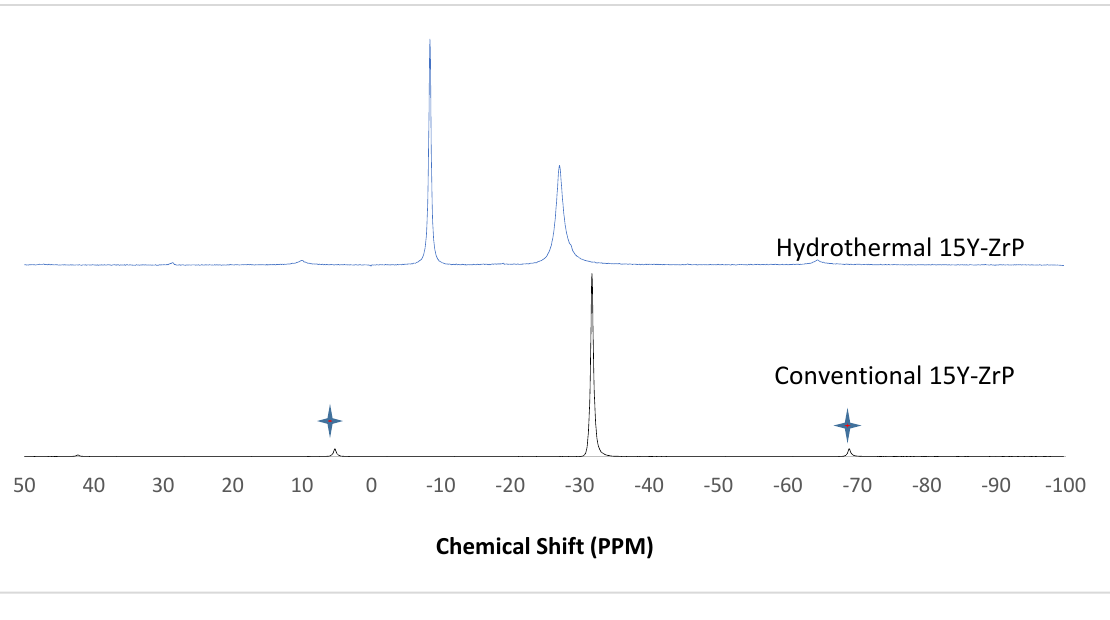
Figure 6. 31 P NMR of α -ZrP synthesised using the two described methods (spinning side bands are shown as ).